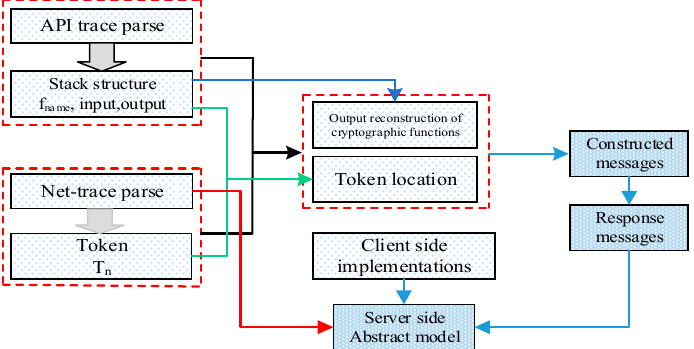
Figure 12. Security analysis method based on MCSPI and the Security Analysis Scheme (SAS) for security protocol implementations.